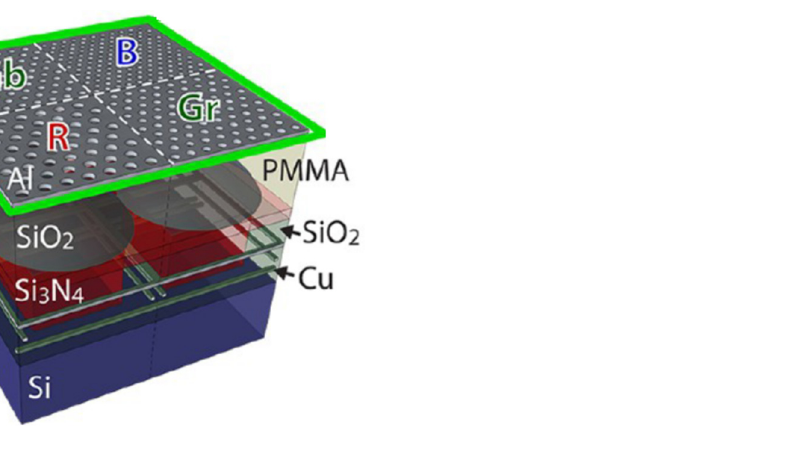
Figure 5. Front-side-illumination CMOS image sensor integrated with RGB plasmonic hole array filters in Bayer mosaic layout.